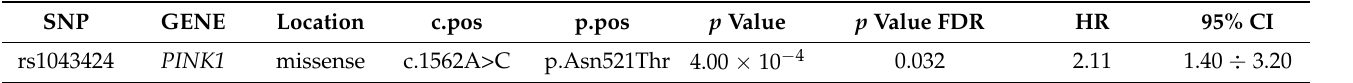
Table 4. The Cox proportional hazard regression results for the association of missense variants with age of onset.